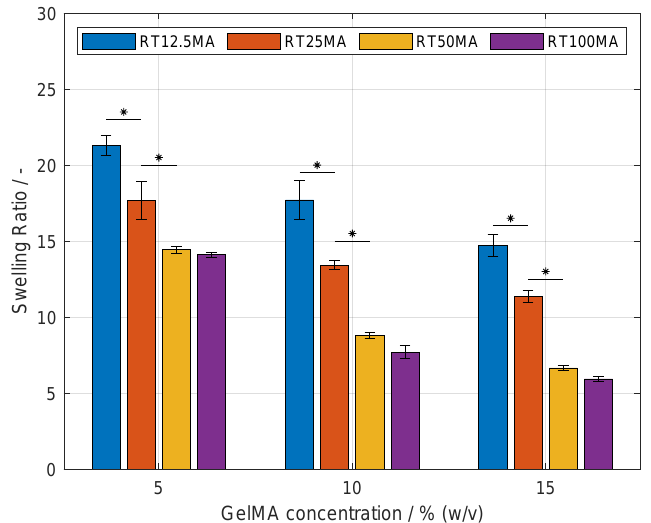
Figure 5. Equilibrium swelling ratio of gelatin methacryloyl (GelMA) hydrogels at various concentra- tions. The swelling behavior increased significantly with higher GelMA concentrations of the same synthesized sample ( p < 0.05). These differences are not shown for the purpose of clarity. Significant differences between the swelling ratio of samples at a constant GelMA concentration are denoted with an asterisk ( p <